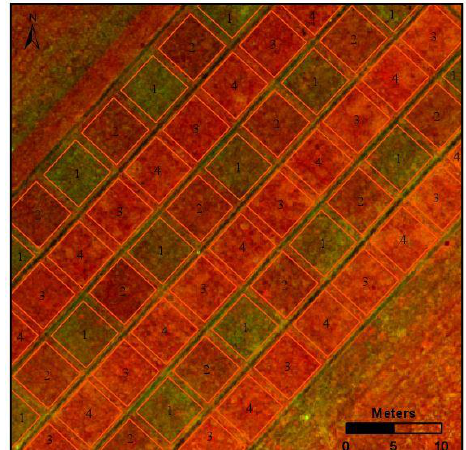
Figure 2. Detailed view of Micasense RedEdge-M based orthomosaic (band order 5-4-3). Numbers inside polygons indicate